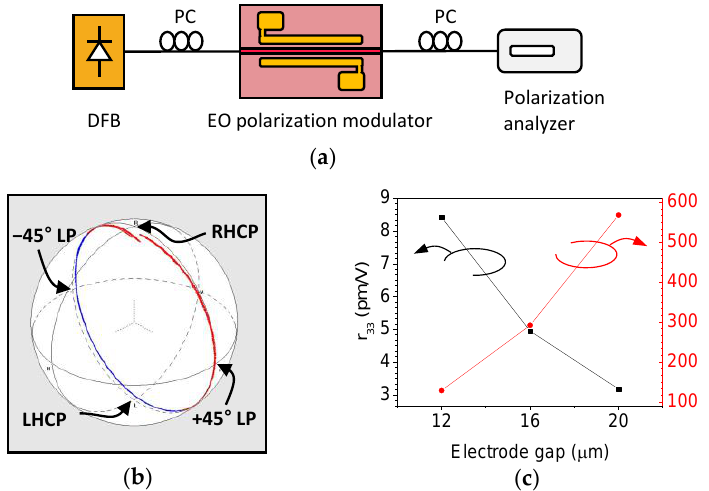
Figure 7. Polarization conversion e ffi ciency measurement using a straight waveguide polarization modulator: ( a ) experimental setup; ( b ) output polarization states measured during polarization modulation, drawn on the Poincare sphere; and ( c ) measured V π and calculated r 33 of poled samples with di ff erent electrode